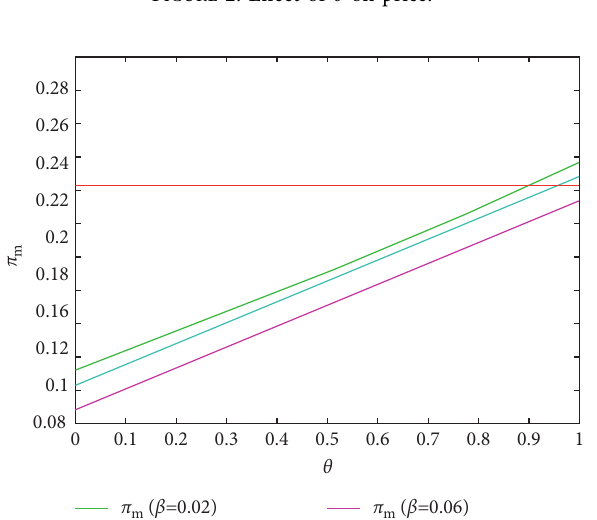
Figure 2: Effect of θ on price.